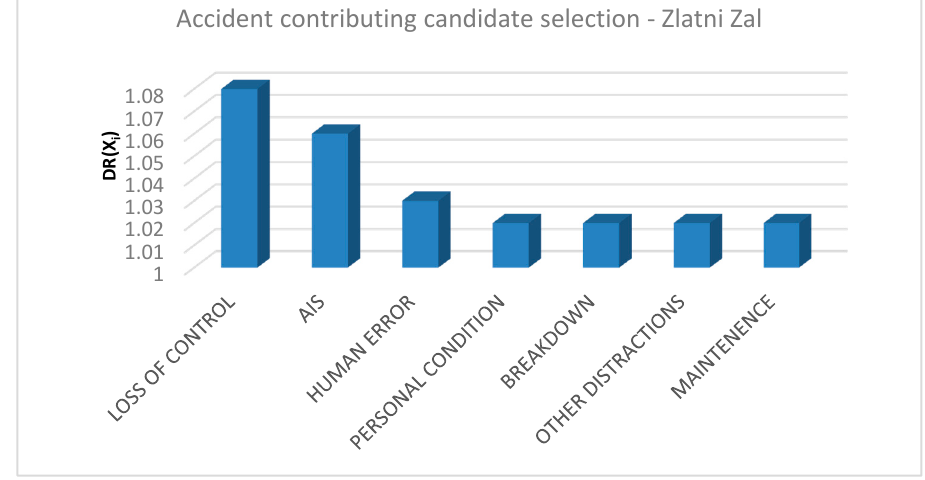
Figure 11. Candidate selection using the Lyapunov-based divergence measure.